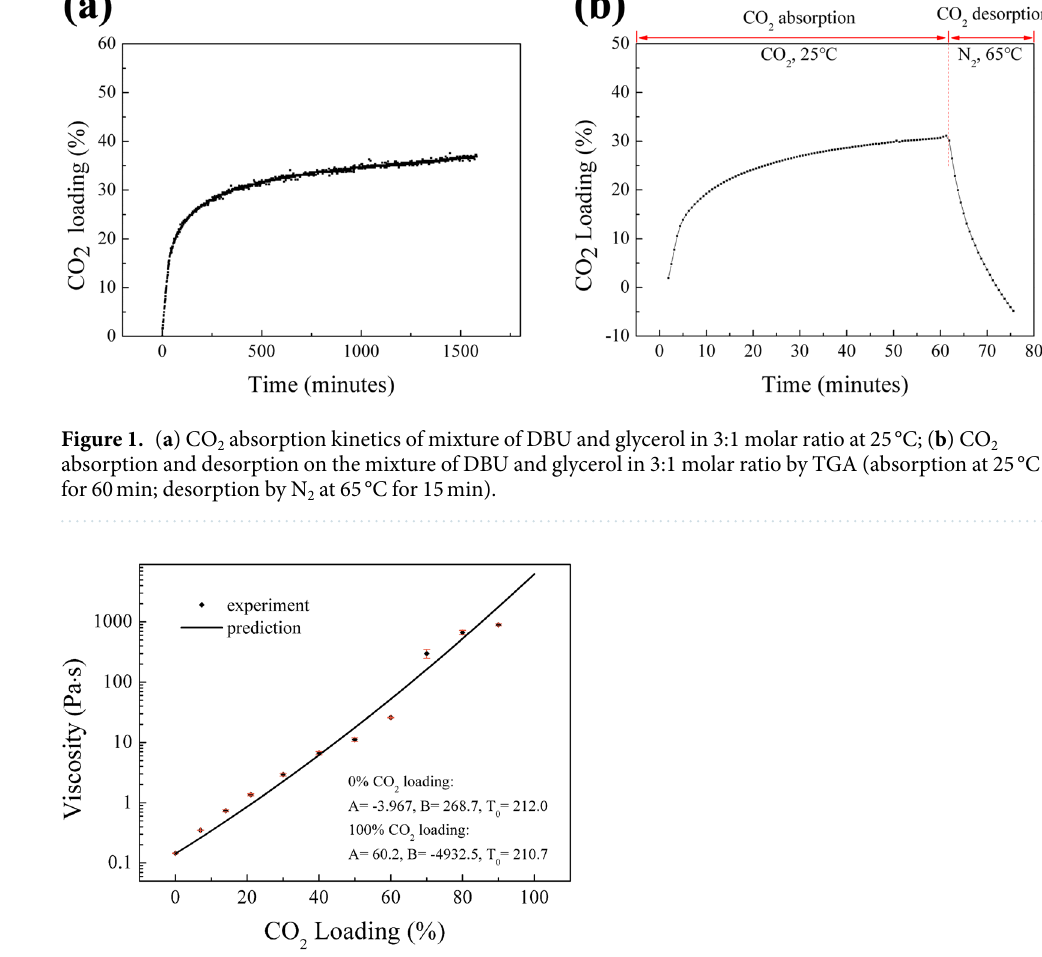
Figure 2. Viscosity as function of CO 2 loading at 25